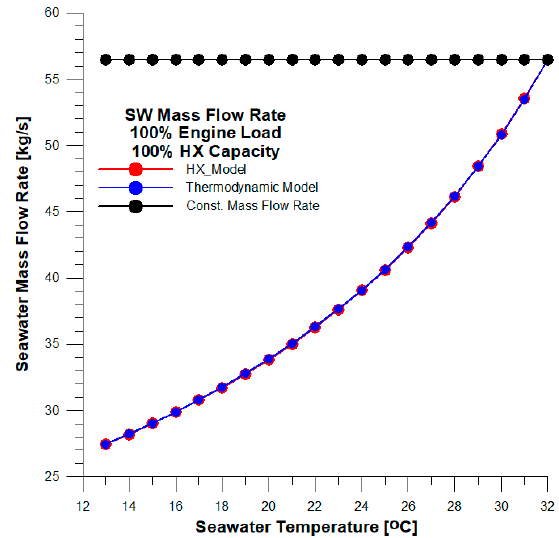
Figure 5. Comparison of seawater mass flow rates as a function of the SW inlet temperature (T t1 ), for central cooler capacity equal to 4251 kW with Variable Speed Drive (VSD) scheme and constant pump speed.